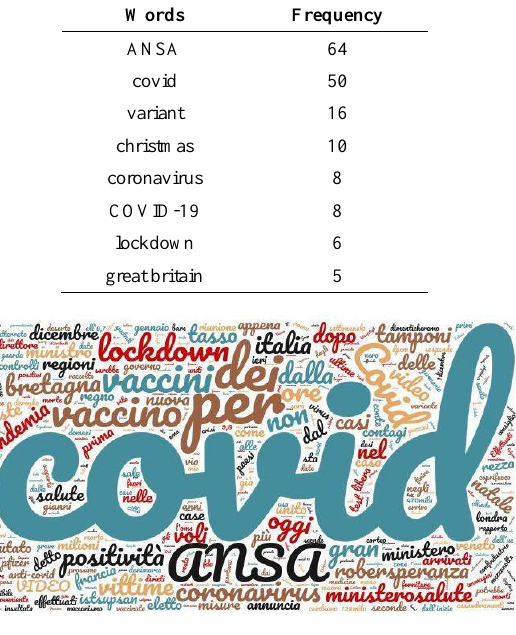
Figure 6. Word Cloud of the most frequent words for